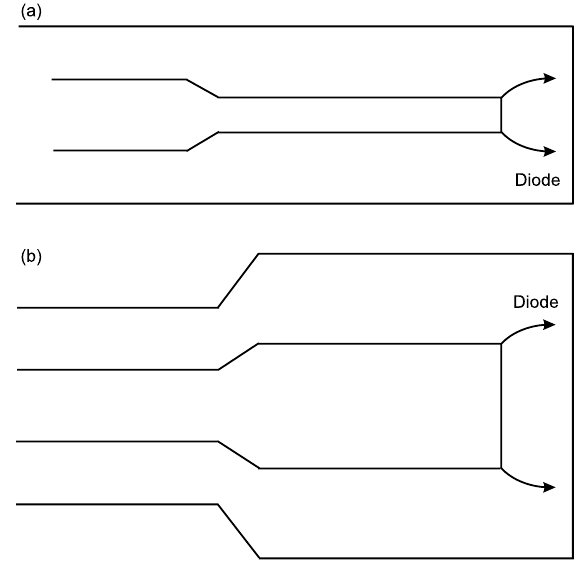
FIG. 19. MITL transitions (a) impedance increases; (b) im- pedance kept constant while diameter